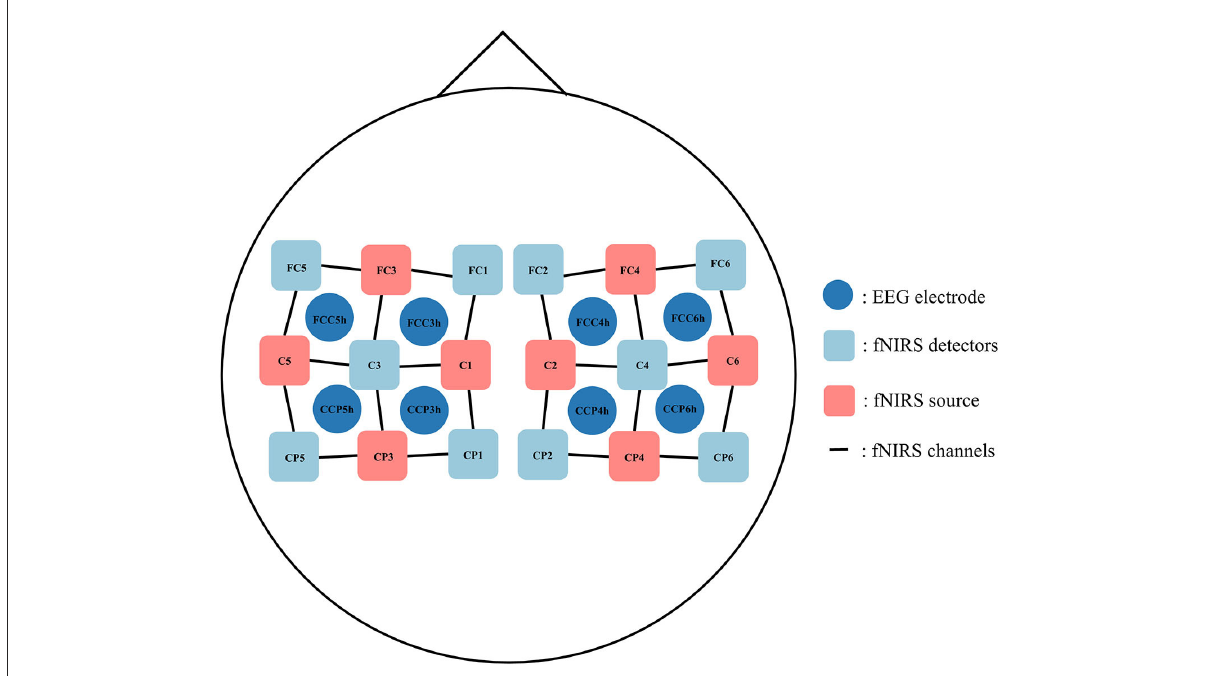
FIGURE1 The placement of EEG electrodes, fNIRS sources, and fNIRS